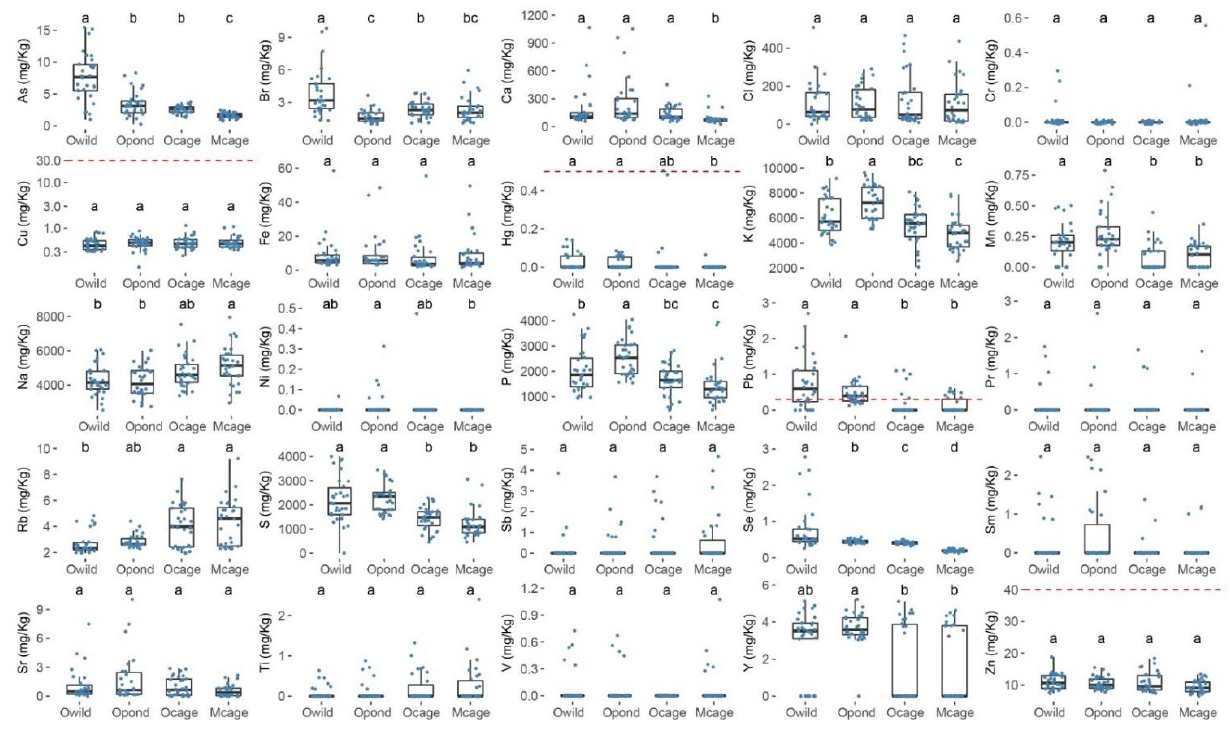
Figure 6. Elemental concentrations (mg/Kg) in the S. aurata muscle (wet weight) of the individuals collected at the following four sampling origins: Olhão – wild (Owild), Olhão – aquaculture in earth ponds (Opond), Olhão – sea-cage aquaculture (Ocage) and Madeira – sea-cage aquaculture (Mcage). The dotted red lines represent the safety threshold, according to the international regulatory authorities. Different statistical letters (a, b, c, and d) denote significant differences between the sampling sites at p < 0.05.